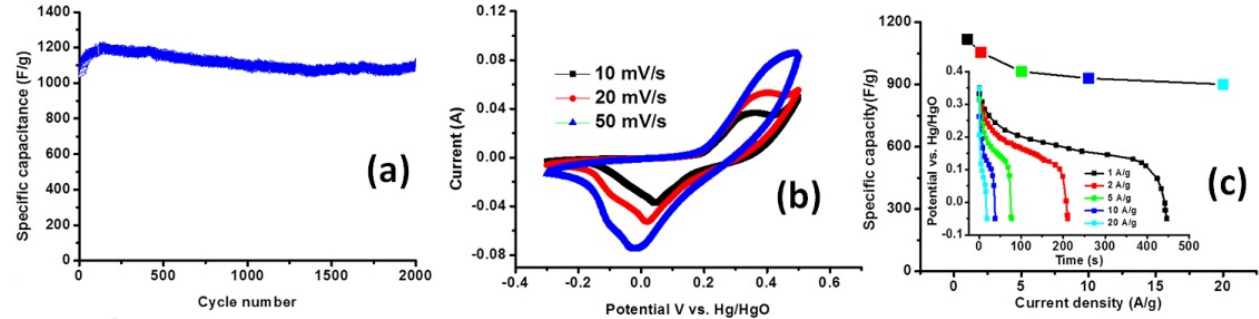
Figure 12. Cycle performance at the current density of 1 A/g ( a ), CV curves at various scan rates ( b ), and average specific capacitance versus discharge current density for GCD ( c ) of G/PANI/Ni(OH) 2 (1:10). Inset shows GCD of G/PANI/Ni(OH) 2 (1:10) at various discharge current densities (Reprinted with permission from [101]. Copyright 2013